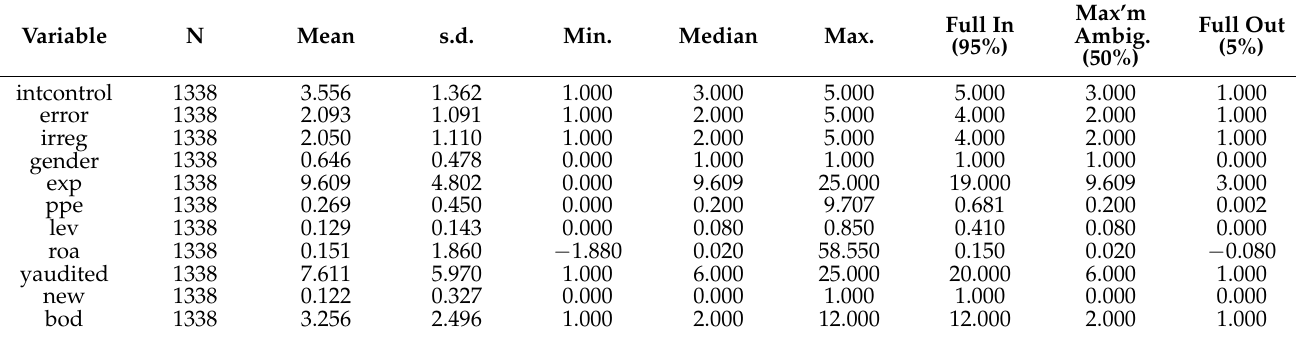
Table 4. Balanced sample descriptive statistics and calibration parameters for